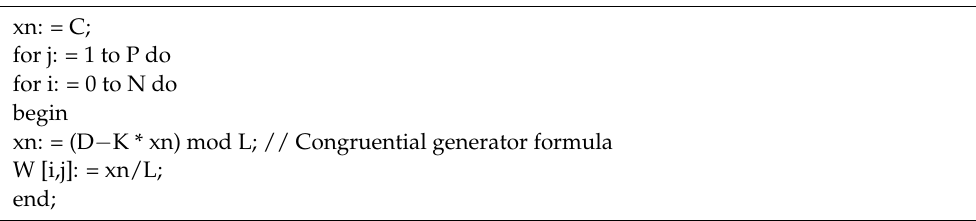
Algorithm 1. Algorithm of matrix W